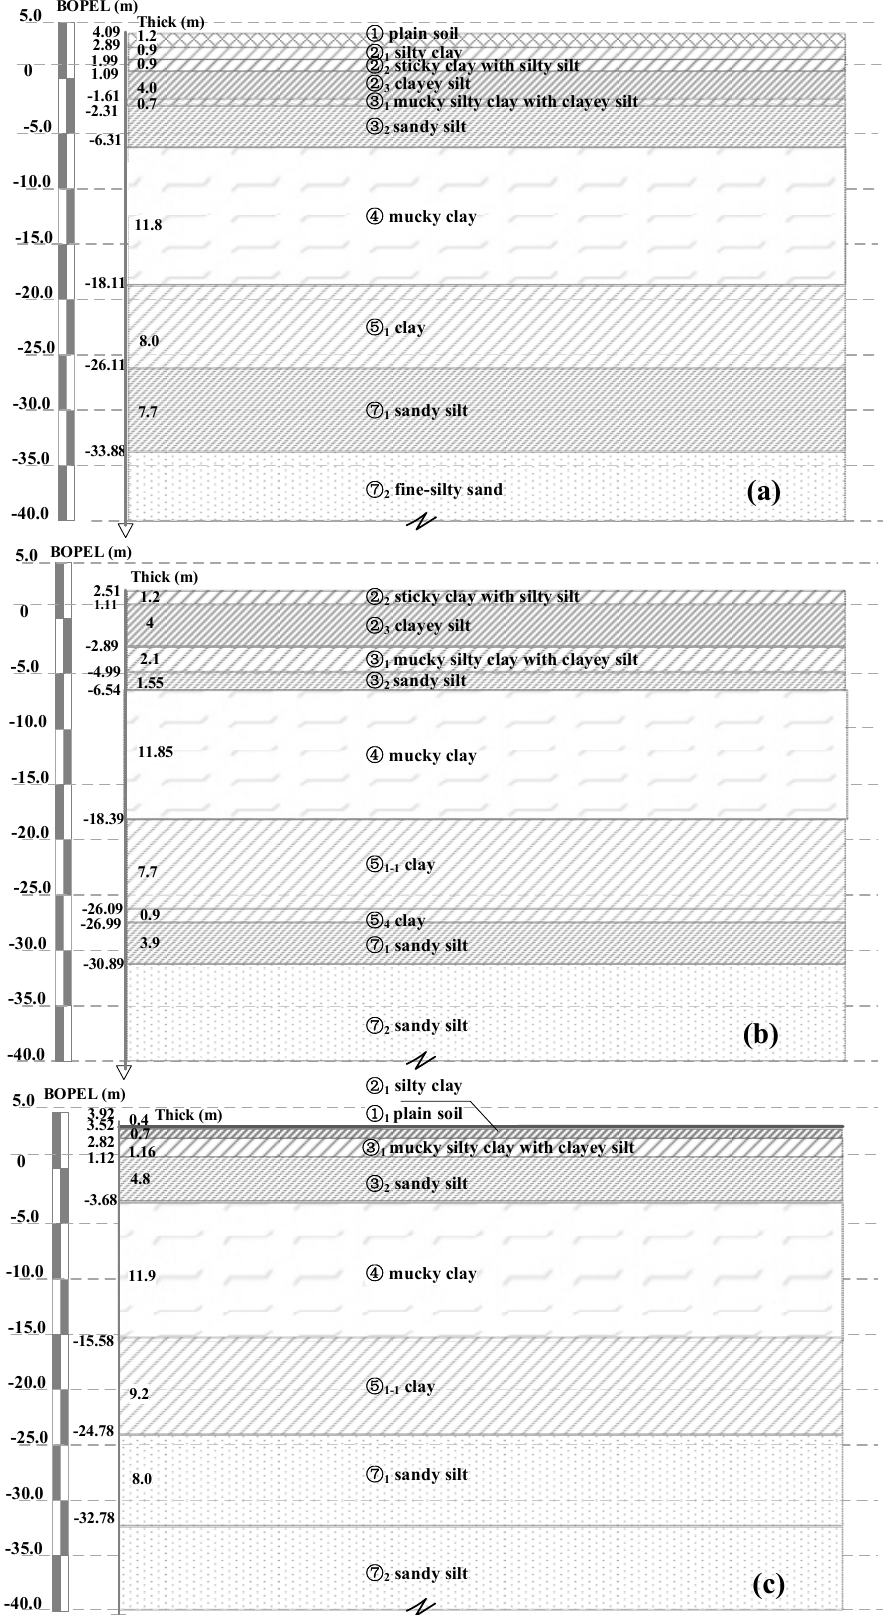
Figure 8. Geological sections of the three runways of Pudong International Airport; among them, ( a ) is the first runway’s geological section; ( b ) is the second runway’s geological section; ( c ) is the third runway’s geological section.